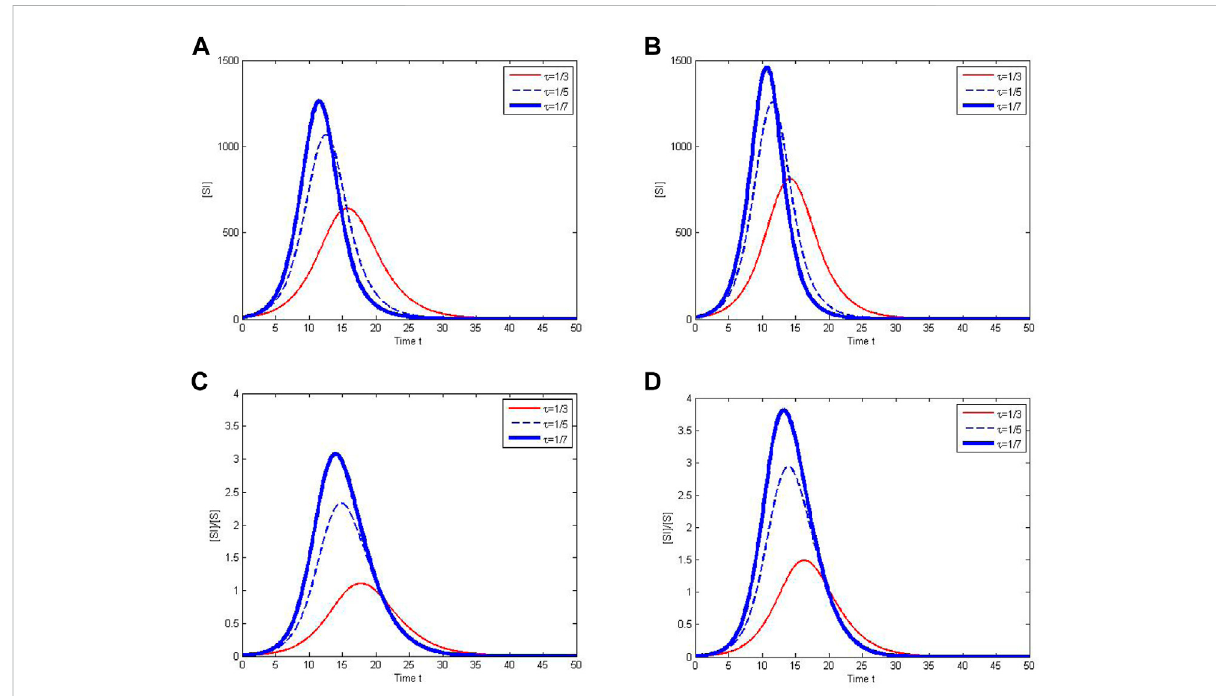
FIGURE 5 The contacts between susceptible and infected individualsunder different tracing rates and awarenessprocesses. In (A) and (C) , theawareness process follows the uniform distribution U (0, 20). In (B) and (D) , the awareness process follows the gamma distribution Gamma (10,